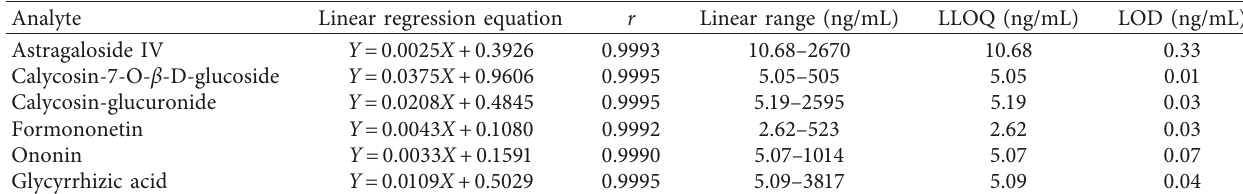
Table 2: Calibration curve of six analytes in mouse plasma.